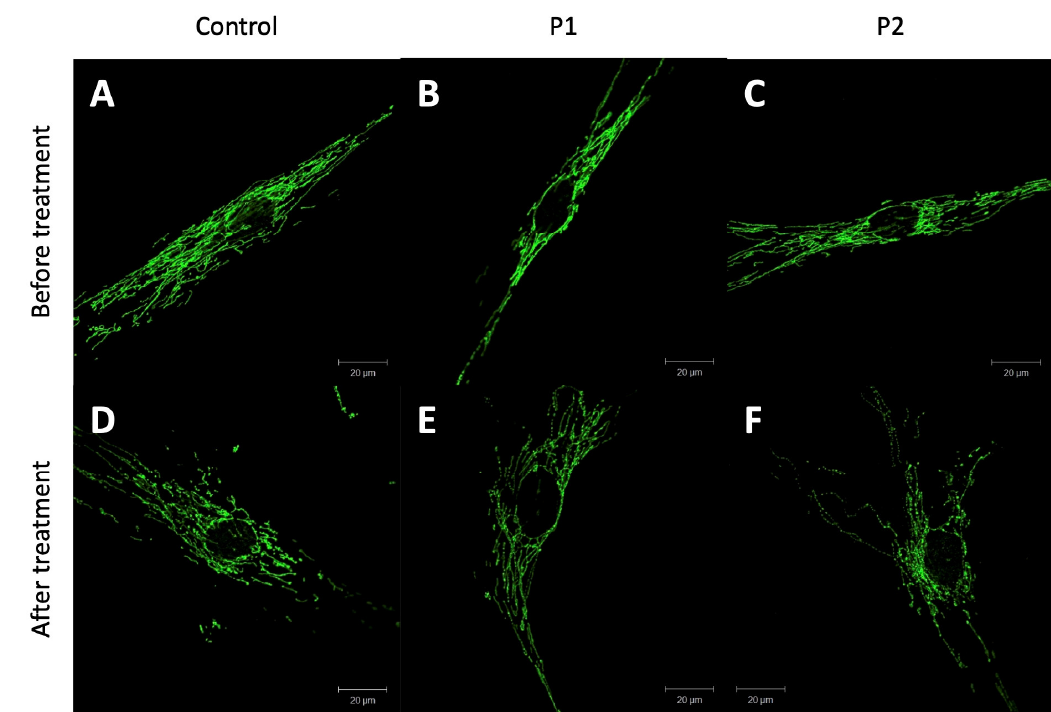
with the truncating variant and normal values in F1 with the missense change (Figure 4). Western blots with the anti-WARS2 antibodies only showed unspecific bands without a Figure 3. Representative pictures of immunostaining of cultured fibroblasts with GRP75 of a control clear band at the expected level of 24.8 kD (see Supplementary Figure 1) and thus could ( A , D ), P1 ( B , E ), and P2 ( C , F ) before ( A – C ) and after paraquat treatment ( D – F ). Figure 3. Representative pictures of immunostaining of cultured fibroblasts with GRP75 of a control not be analyzed. ( A , D ), P1 ( B , E ), and P2 ( C , F ) before ( A – C ) and after paraquat treatment ( D – F ).